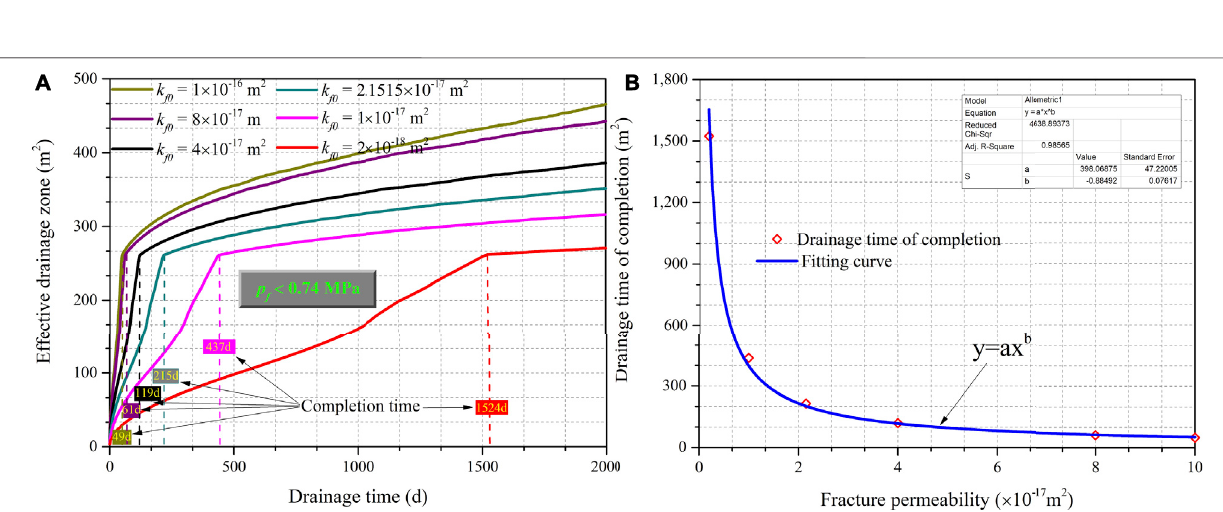
Frontiers in Energy Research |